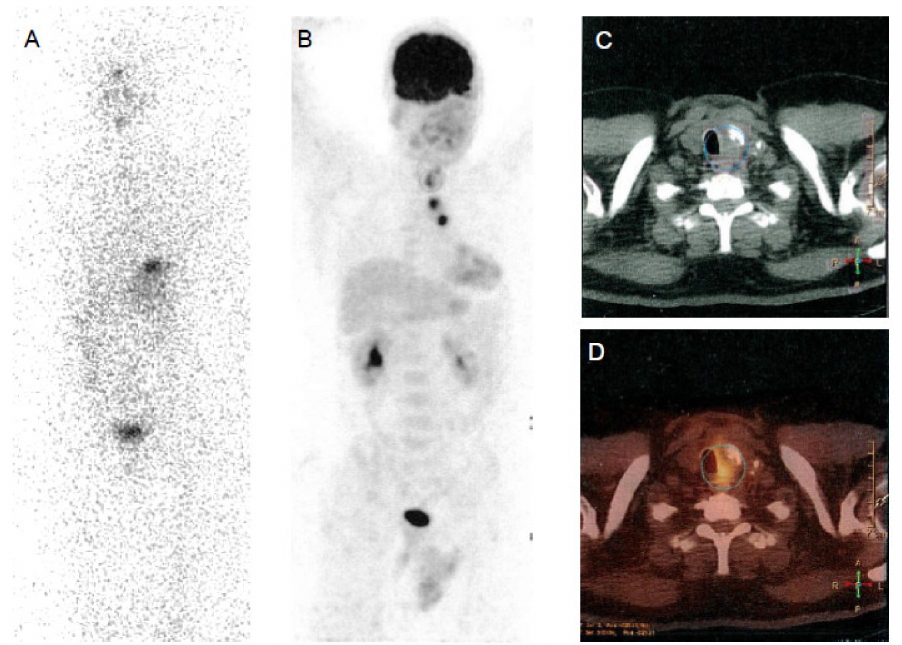
Figure 2. Papillary thyroid cancer in a 30-year-old woman. Post-therapy ( A ) 131 I whole-body scan and 18 F-FDG PET-CT ( B,C,D ) images. Post-therapy 131 I whole-body scan did not show areas of uptake ( A ). 18 F-FDG PET-CT images evidenced multiple areas of increased uptake in the left retrosternal and latero-cervical